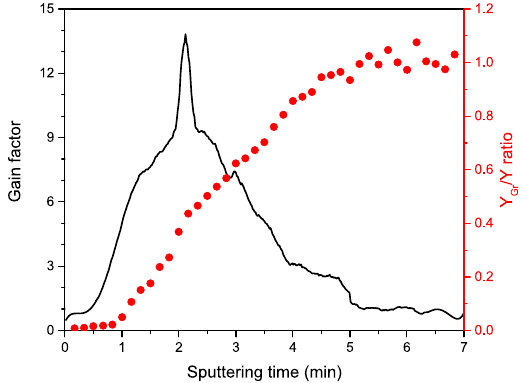
Figure 8. A comparison of the gain change during sputtering in dSIMS mode and the Y Gr / Y ratio for Si dopant in AlGaAs substrate. Close to the optimal condition the Y Gr / Y ratio increases significantly whereas the enhanced ionization probability is still